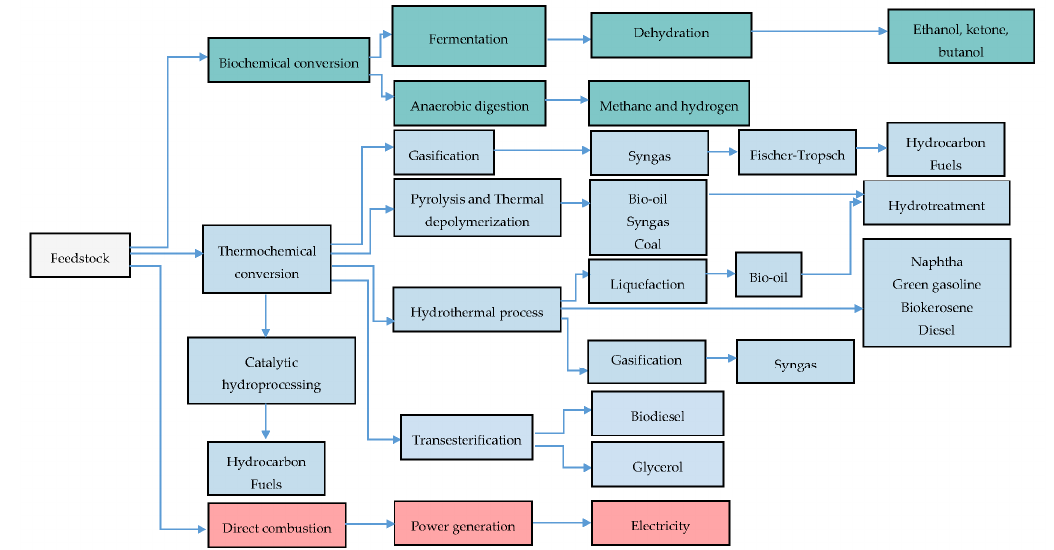
Figure 1. Technological processes for the production of biofuels [2–4].